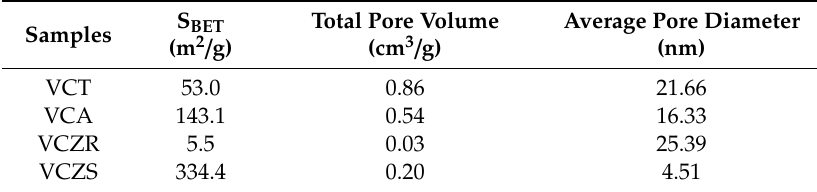
Figure 2. HR-TEM image ( a , b ) and SEM-EDS mapping images ( c , d ) of V-Ce oxides supported on TiO 2 (VCT).